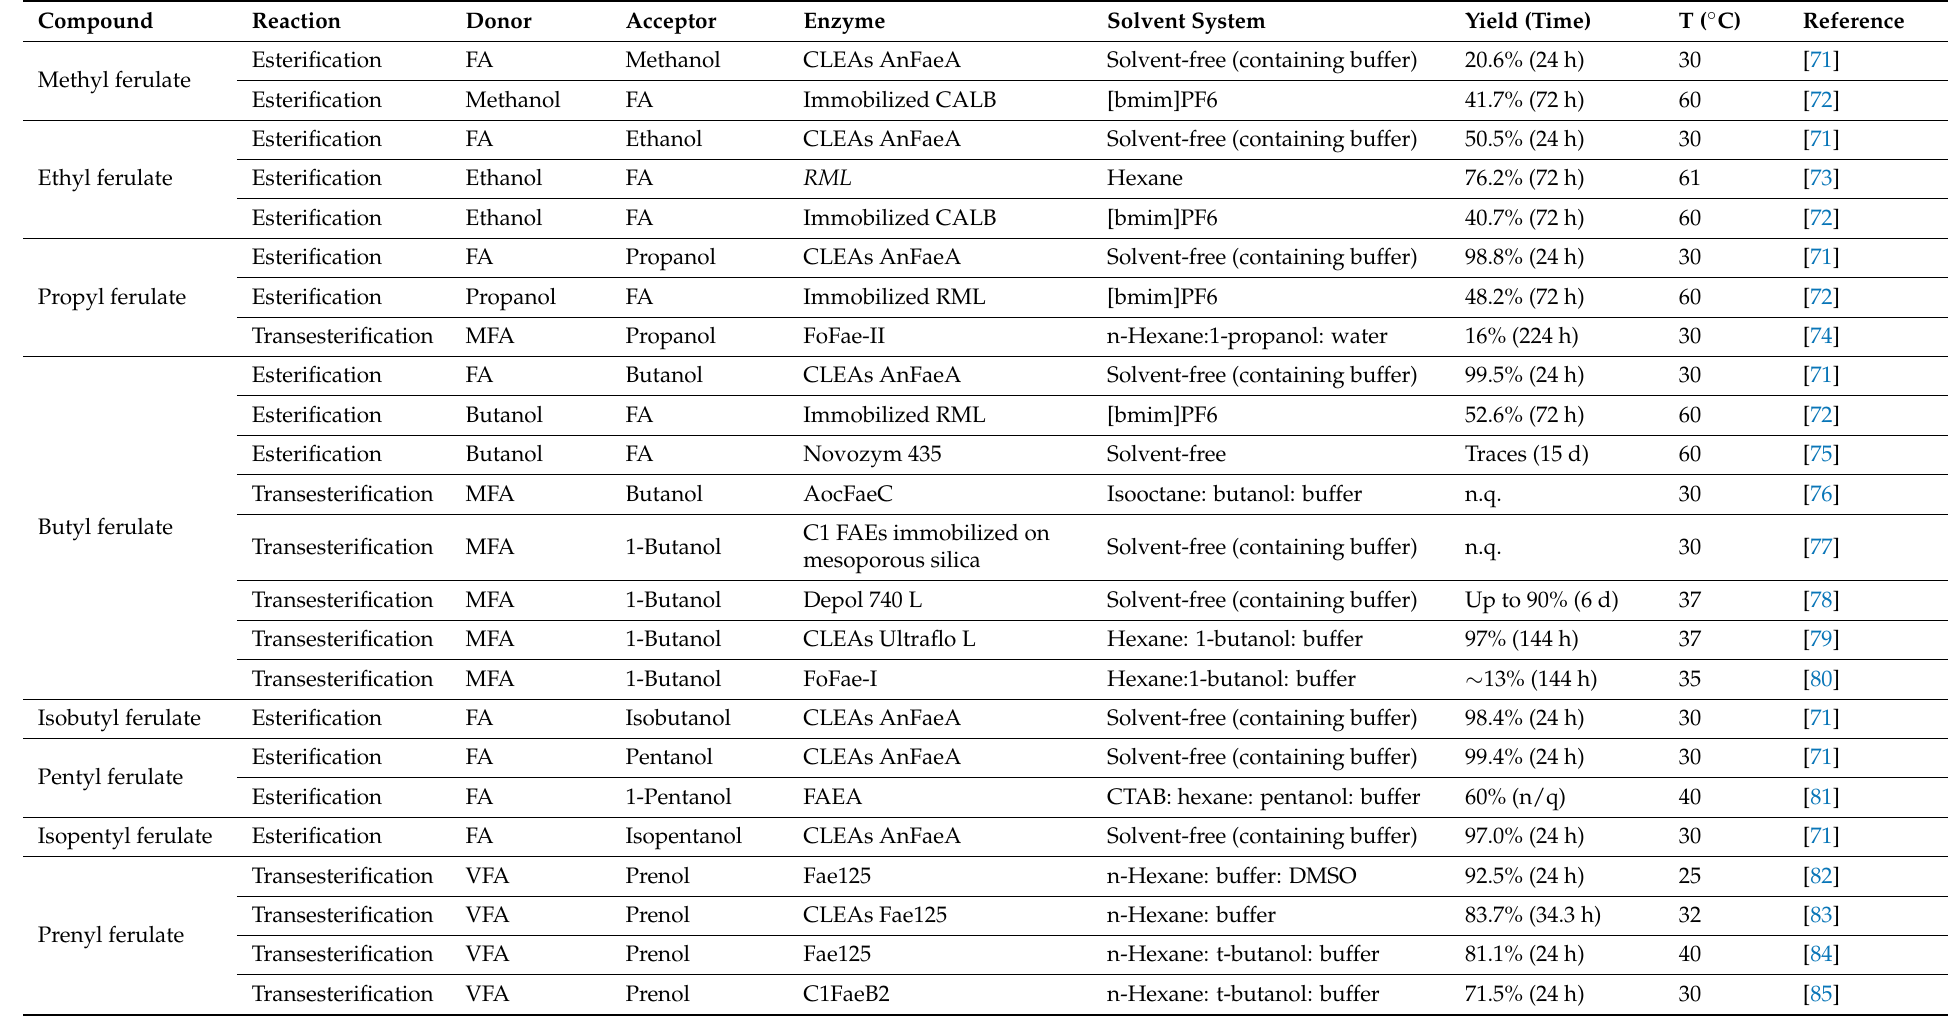
Table 1. Listing and synthesis methods of enzymatically synthesized FA